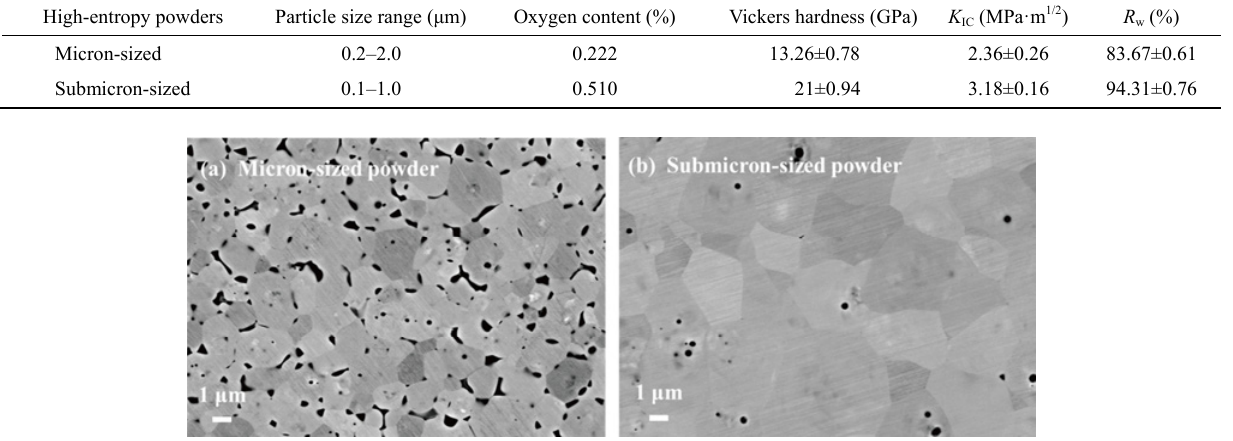
Fig. 6 SEM images of ceramics fabricated with synthesized high-entropy powders with different